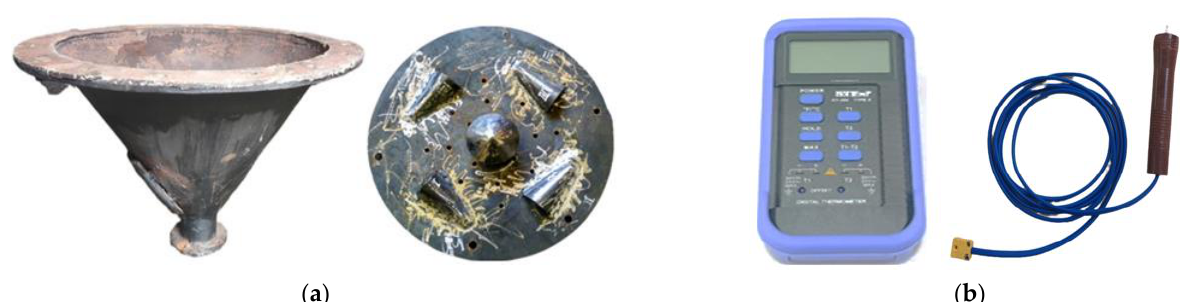
Figure 3. ( a ) Modification of hollow plate with four spoons and ( b ) digital thermometer and thermocouple for measure- ment data. Table 1. Specifications of the Thermometer Digital